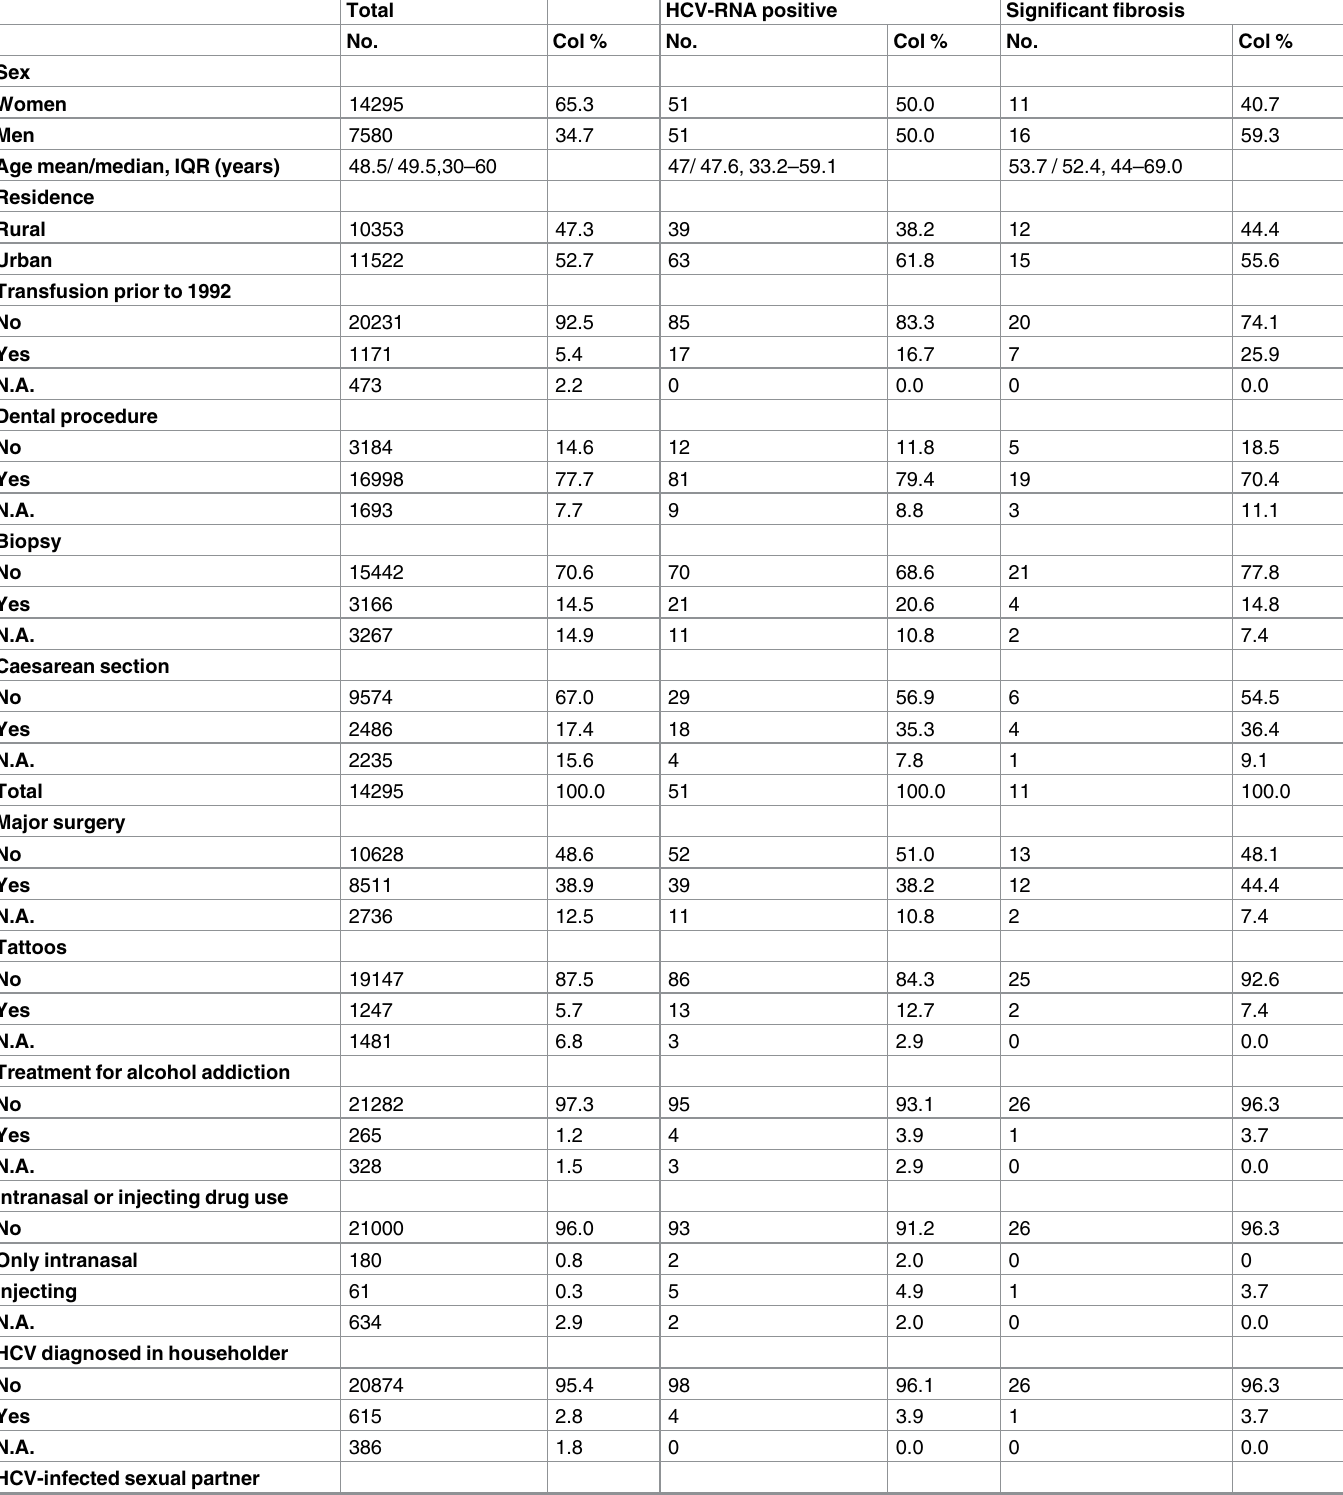
Table 1. Characteristics of the study population, HCV-infected individuals and individuals with indication of significant liver fibrosis. Total